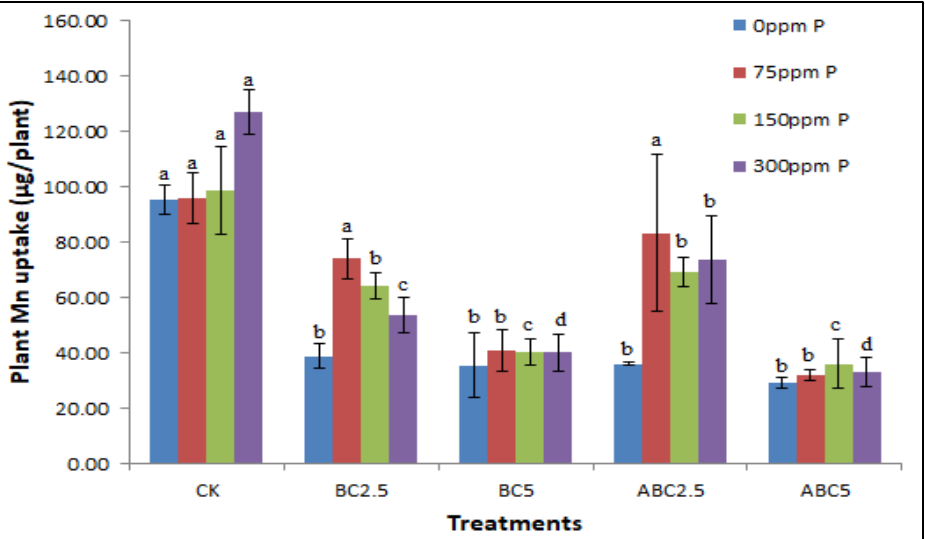
Figure 12. Effects of BC and ABC applied at different rates with different P fertilizer application rates on Plant Mn uptake ( μ g/plant). Means with different letters within each fertilizer rate across each treatment indicate significant differences according to the least significant difference (LSD) test at p < 0.05. CK = Control, BC2.5 = Biochar added at 2.5% w / w , BC5 = Biochar added at 5% w / w , ABC2.5 = Acidified biochar added at 2.5% w / w , and ABC5 = Acidified biochar added at 5% w / w .